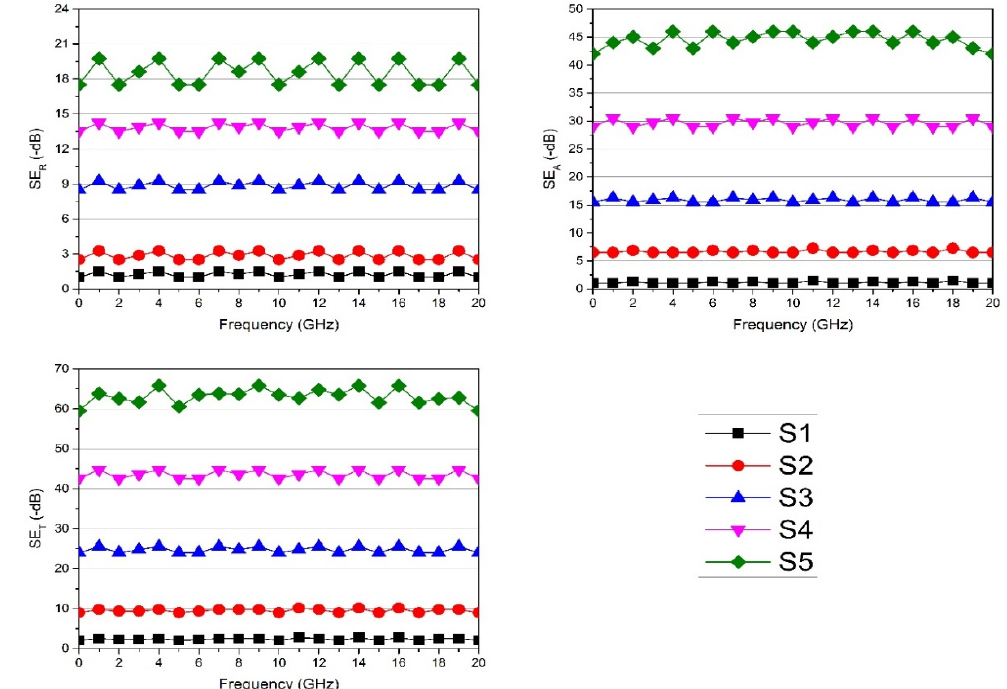
Figure 9. Measured EMI shielding of prepared nanocomposite films through VNA ( a ) SE R , ( b ) SE A , and ( c ) SE T .